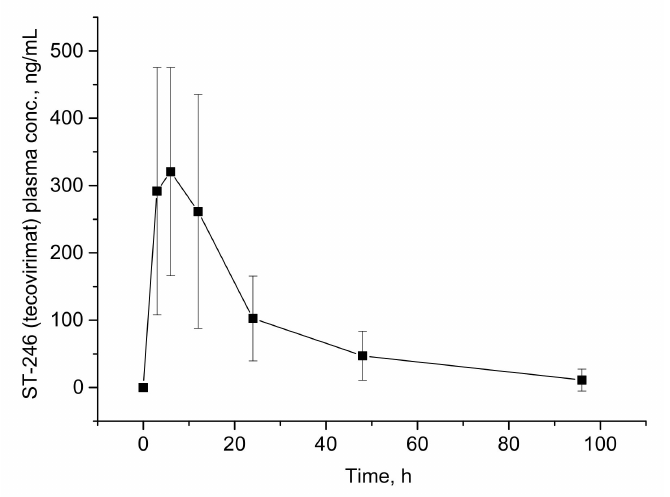
Figure 4. The mean plasma concentration–versus–time plot of ST-246 (tecovirimat) as the main immediate metabolite of NIOCH-14 after single oral administration of 600 mg of NIOCH-14 to healthy human volunteers ( n = 4).